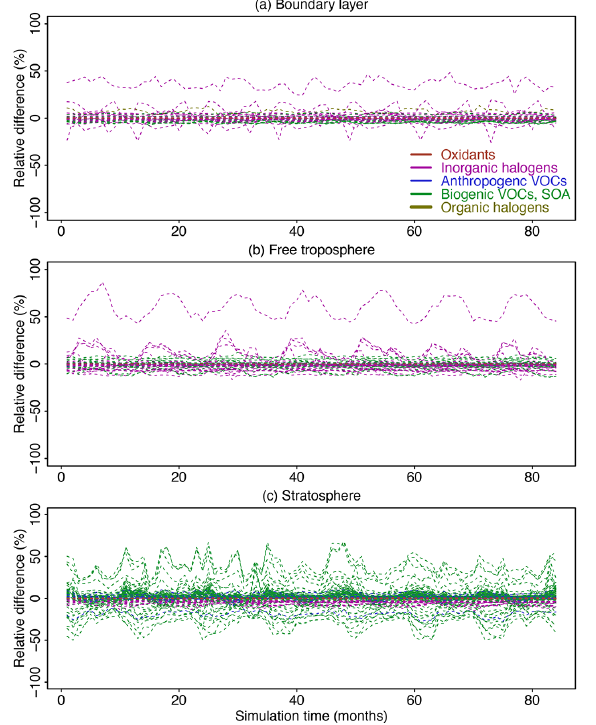
Figure 8. Relative difference of atmospheric masses in the adap- tive reduced chemistry mechanism algorithm over an 8-year GEOS- Chem simulation using a threshold δ of 1500 moleculescm − 3 s − 1 to separate fast and slow species. We show the RRMSE in the (a) boundary layer, (b) free troposphere, and (c) stratosphere. Dif- ferent colors denote different species categories (more details can be found in Table 1). Figure S7 presents more detailed results for the species with RRMSEs in the − 1 . 5% to 1.5%